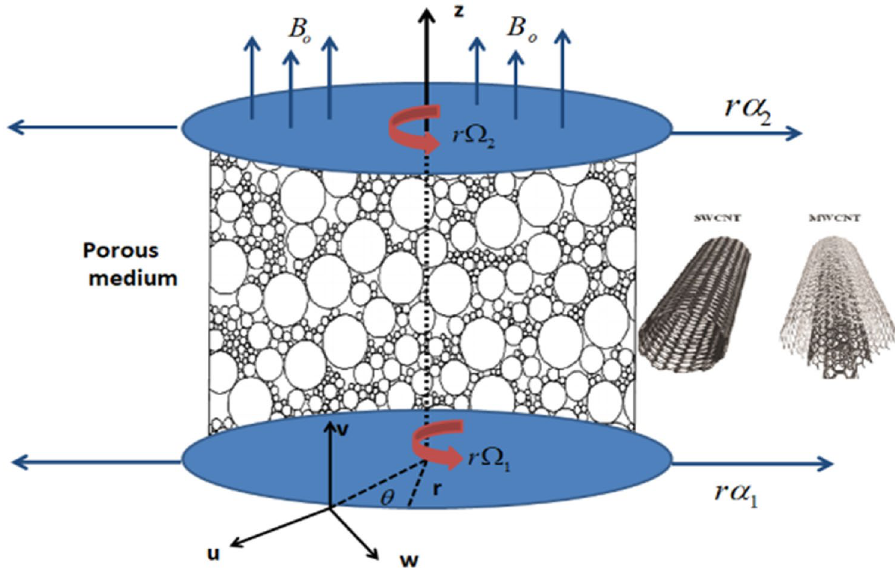
Figure 1. Geometry of the problem.